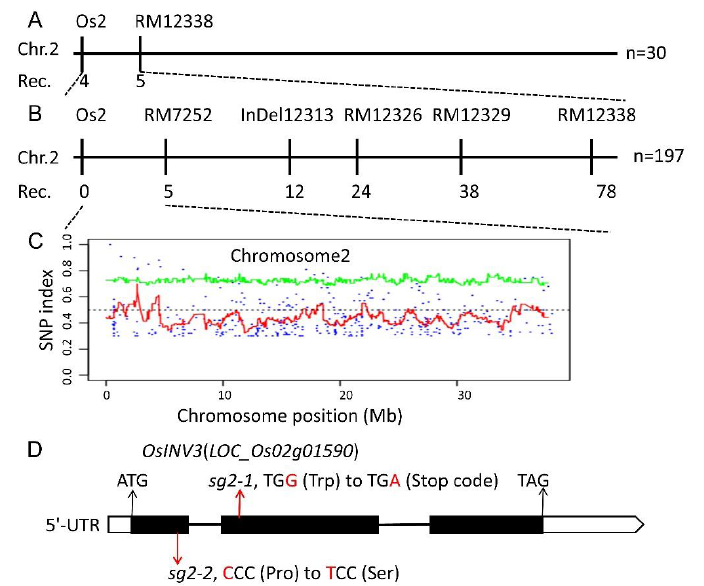
Figure 3. Positional cloning of SG2 . ( A ) The SG2 gene is located on chromosome 2 between InDel marker Os2 and SSR marker RM12338. ( B ) Then SG2 gene is delimited to the region between Os2 and RM7252 using 197 F 2 mutant individuals. ( C ) Manhattan plot of chromosome 2. ( D ) The gene structure of SG2 . Black boxes, lines and white boxes represent exons, introns and the untranslated regions, respectively. The start codon (ATG) and the stop codon (TAG) are indicated. The sg2 mutations in the SG2 gene is